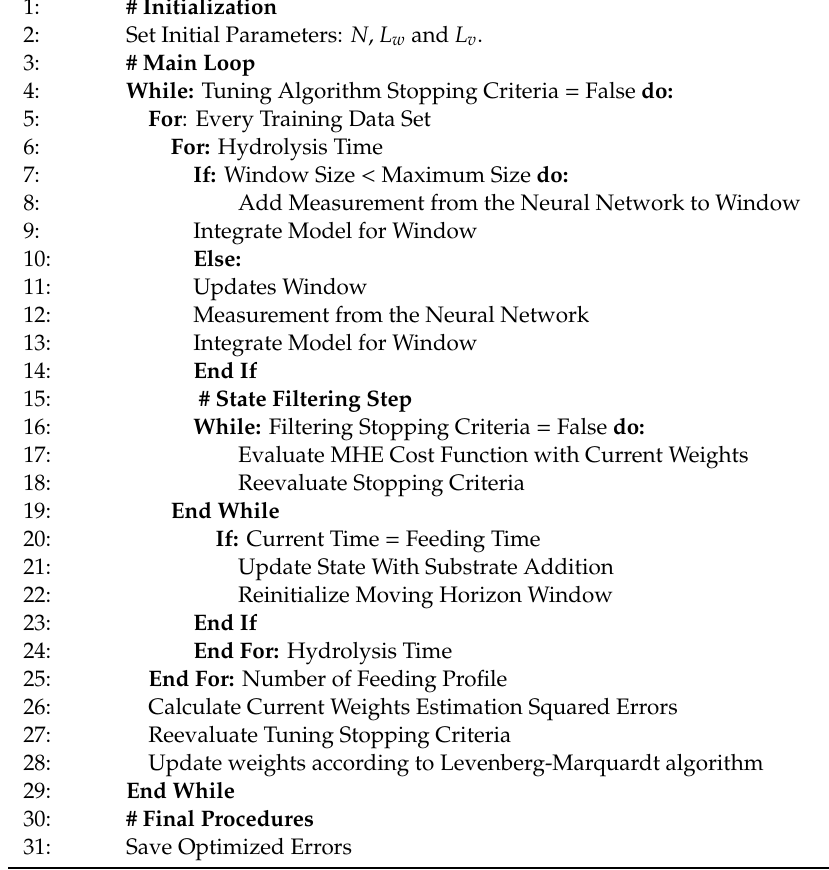
Table 3. Moving Horizon Estimator (MHE) Tuning